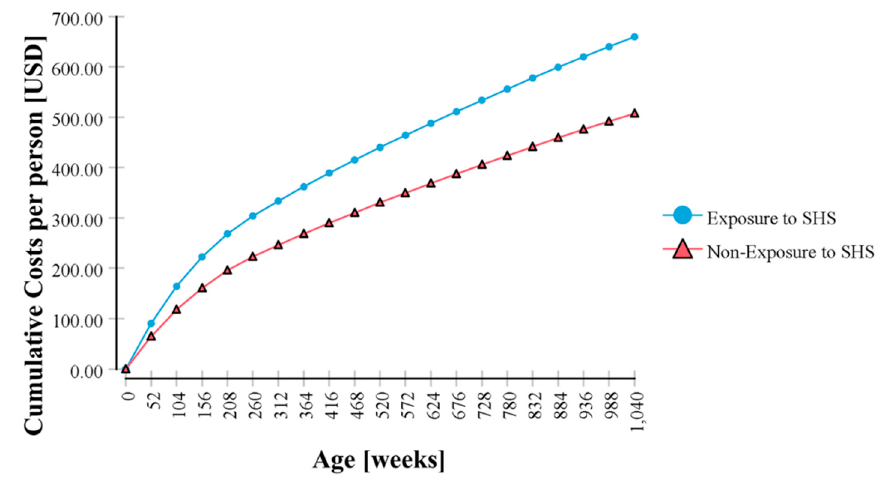
Figure 2. Cumulative healthcare costs for 20 years in Korean children who were exposed to secondhand smoke (SHS) at home compared with nonexposed children.